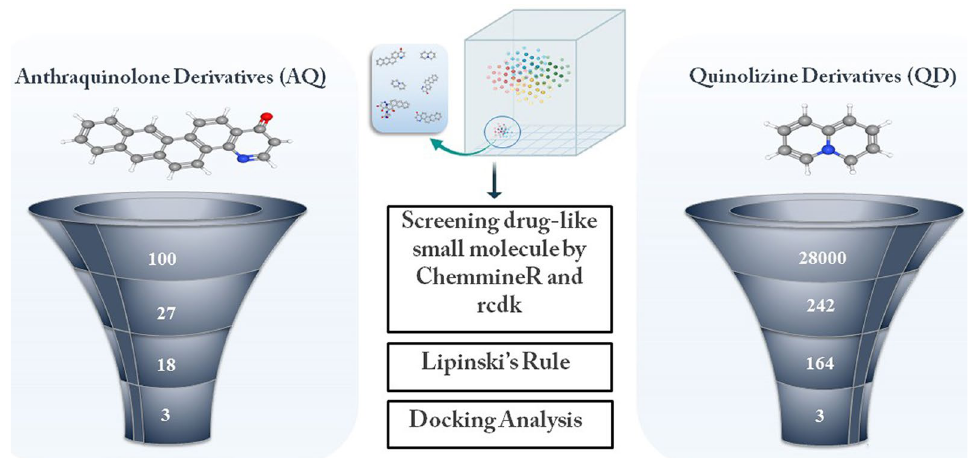
Figure 2. Pipeline of screened AQ and QZ derivatives to top 3 most potent